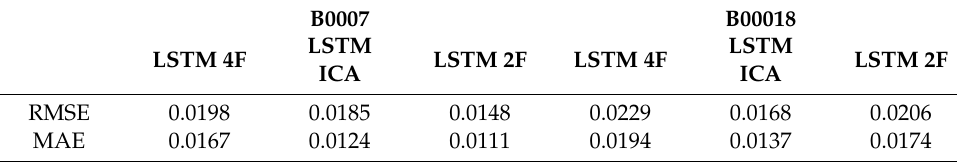
Table 5. The loss rate of 7# and